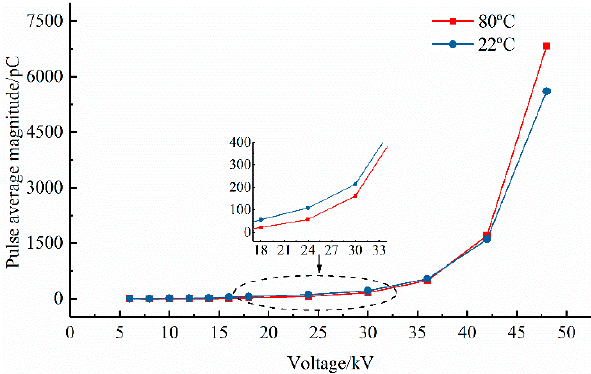
Figure 9. Trend of pulse average magnitude.